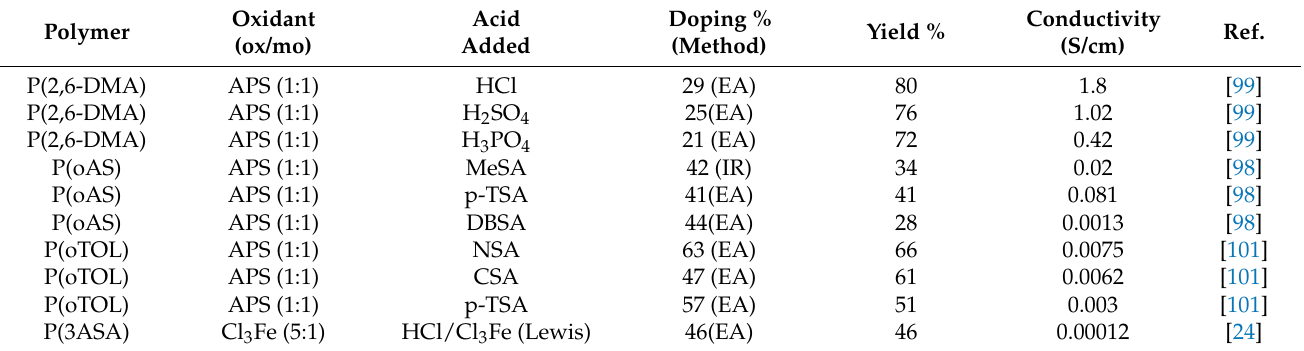
Table 4. Effect of acid added to MCP of substituted anilines on the yield and conductivity of the